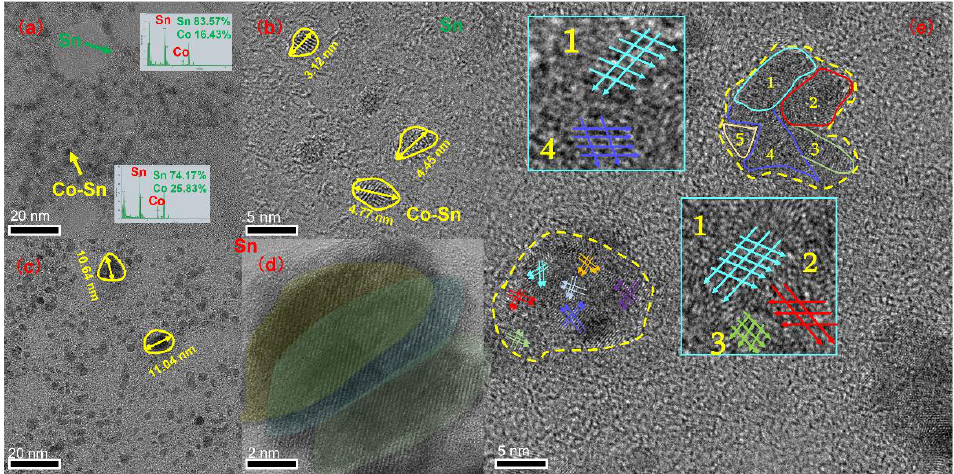
Figure 8. CoSn 3 nanoparticles after heating for 0 min at 350 °C. ( a ) TEM image; ( b ) TEM image; ( c ) TEM image; ( d ) Mohr pattern; ( e ) orientation unification. The number represents the sampling area. If the contact area of two particles is less than 50% of the cross-sectional area of the